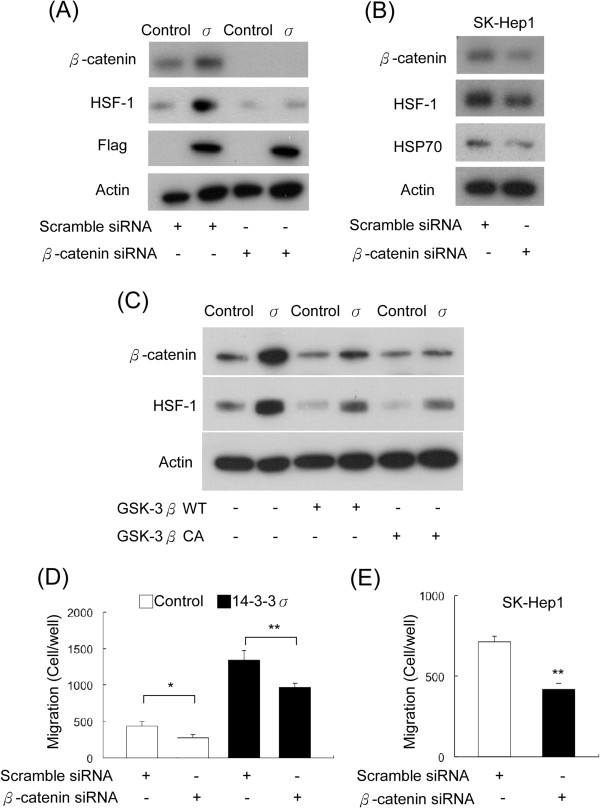
14-3-3σ induces HSF-1 expression via regulating β-catenin. (A) 14-3-3σ-induced HSF-1 expression was abolished by knockdown of β-catenin in stable cells and (B) SK-Hep1 cells. (C) 14-3-3σ-induced HSF-1 expression was attenuated by overexpression with wild type (WT) and constitutively activated (CA) mutant of GSK-3β. Expression of β-catenin, HSF-1, HSP70 and Flag was determined by Western blot analysis. Actin was used as a loading control. (D) Migratory ability was determined by a Boyden chamber assay. Knockdown of β-catenin with siRNA suppressed cell migration in 14-3-3σ stably overexpressed cells and (E) SK-Hep1 cells. Scale bars: mean ± SD. *P < 0.05, **P < 0.01.